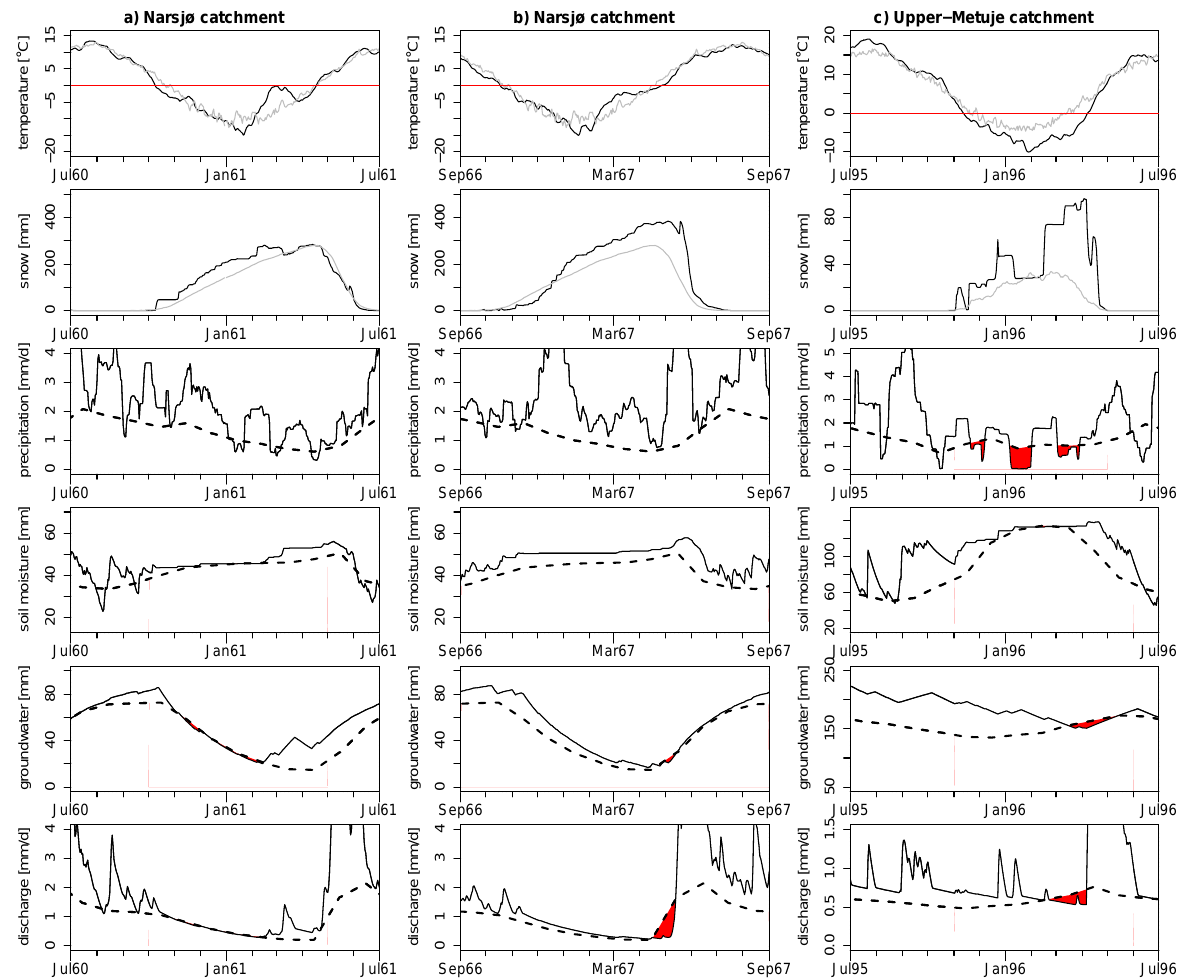
Fig. 8. Examples of cold snow season drought type: (a) Narsjø catchment 1960–1961, (b) Narsjø catchment 1966–1967, (c) Upper-Metuje catchment 1995–1996 (legend: see Fig.